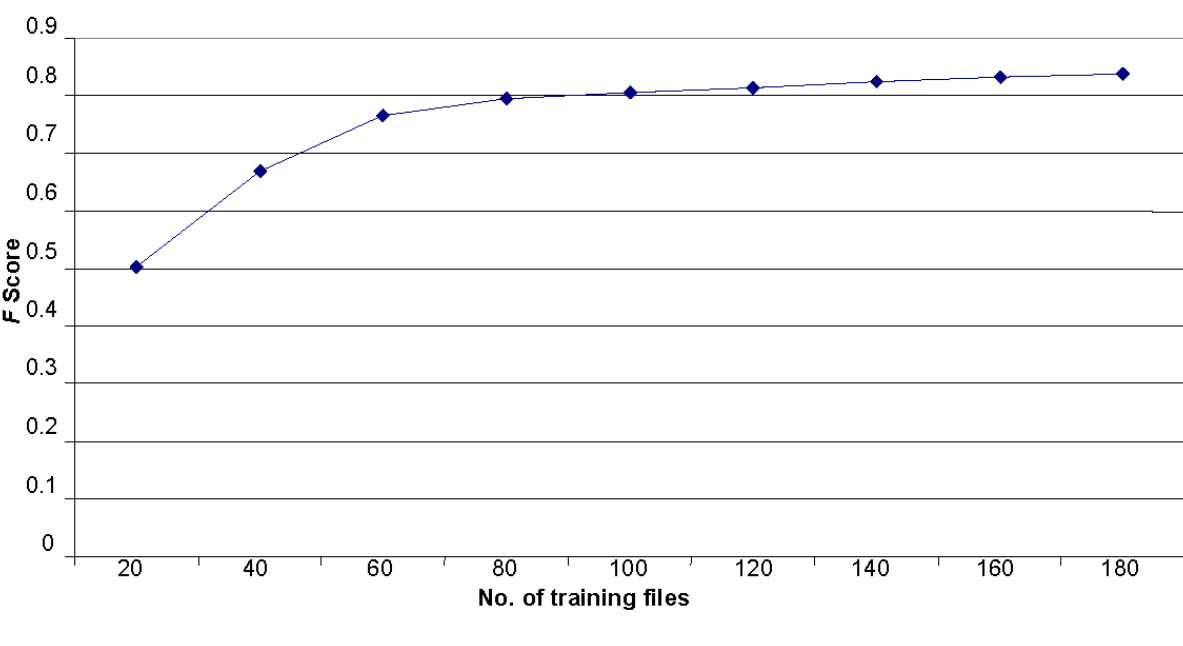
Figure 6. Dependency of the F score and the training data volume for the author attribution.